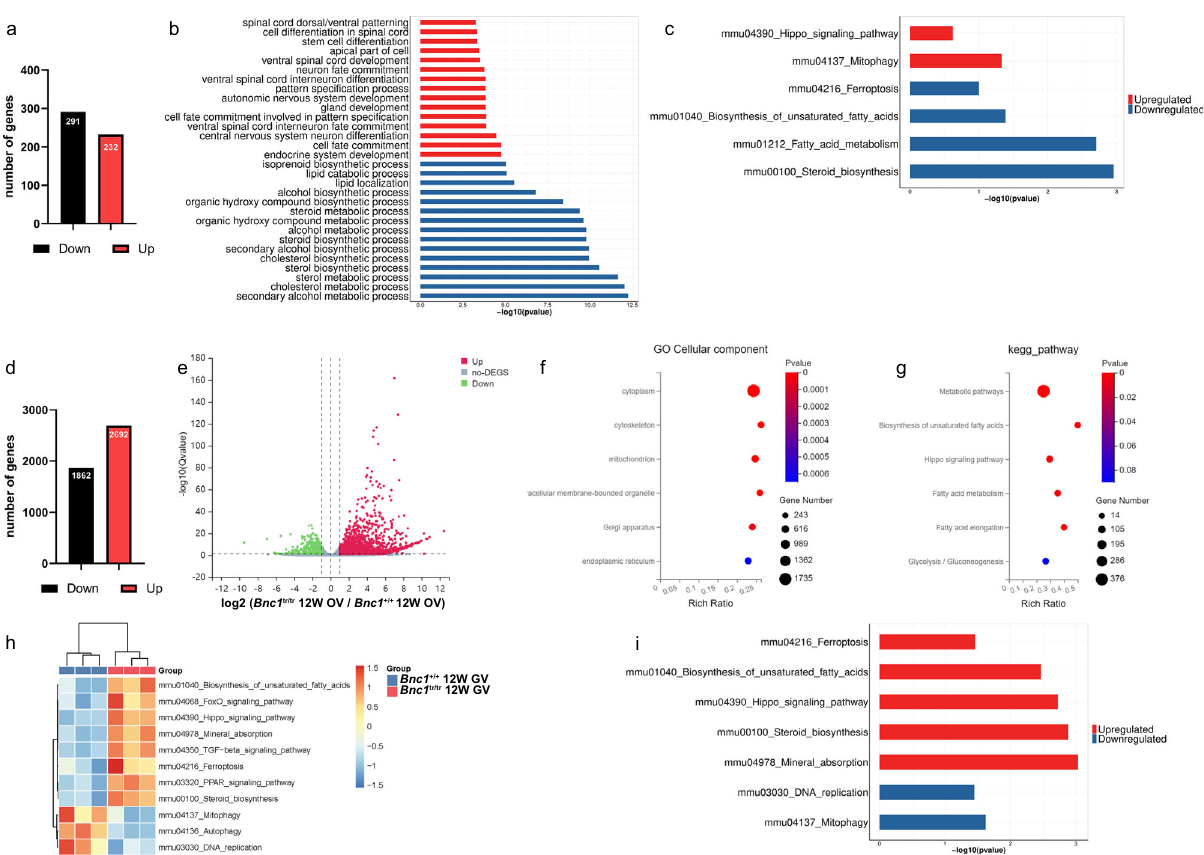
Fig.4| Bnc1 mutationmayinducefollicularatresiathroughferroptosis.a DEGs of Bnc1 +/+ ( n =3) and Bnc1 tr/tr ( n = 3) mouse ovaries. b KEGG analysis of Bnc1 +/+ and Bnc1 tr/tr mouse ovary RNA-seq data (Top signi fi cantly (FDR < 0.05, Benjamini – Hochberg p adjustment)). c GSVA of Bn c 1 +/+ and Bnc1 tr/tr mouse ovary RNA-seqdata(Wilcoxtest p value). d , e DEGs of Bnc1 +/+ ( n =3)and Bnc1 tr/tr